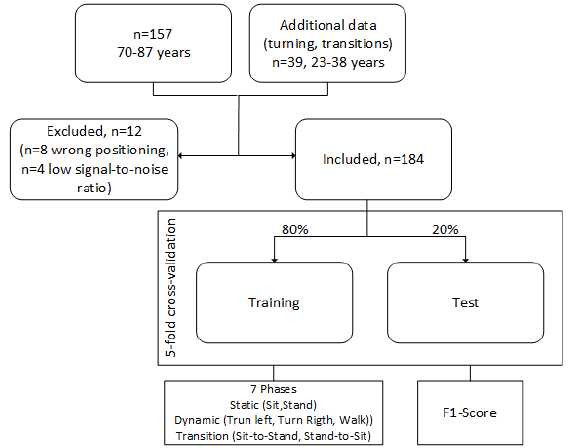
Figure 2. Used data for the machine learning model. Additional data of a younger study population ( n = 20, aged 23–37 years) was included for optimization of the recognition of turnings and